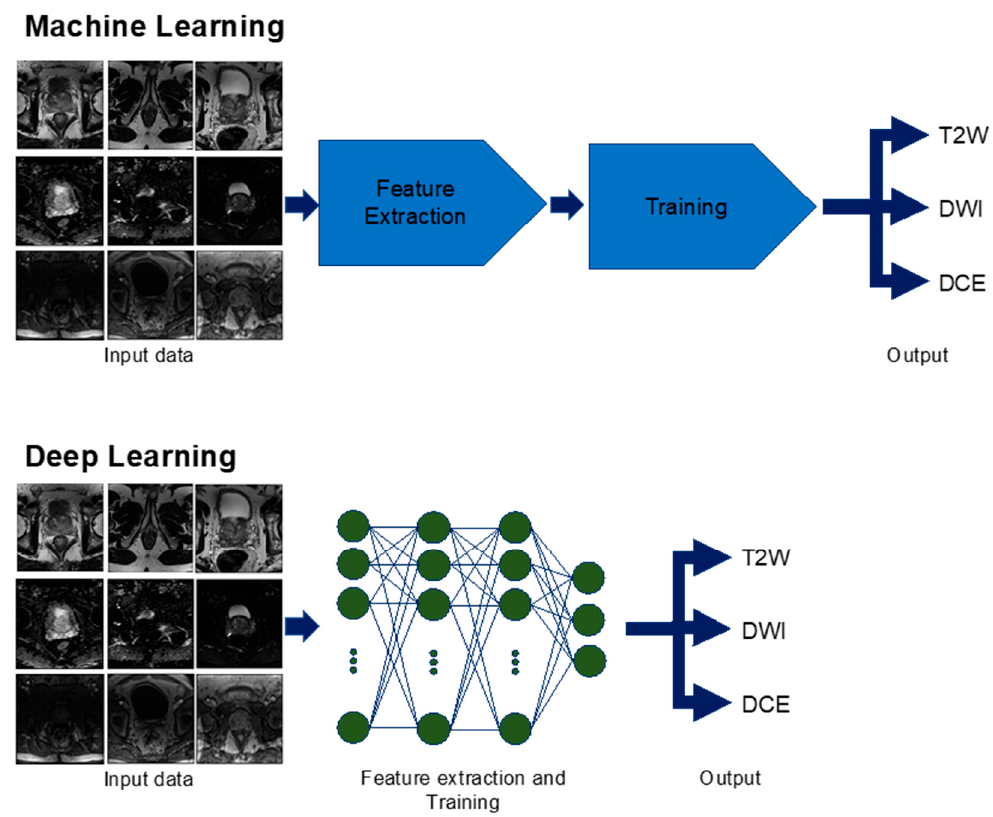
Figure 2. Machine learning versus deep learning used for multiparametric magnetic resonance imaging (mpMRI) sequence identification. In machine learning, the computer receives inputs of mpMRI images and goes through feature extraction specific to the di ff erent sequences of T2-weighted (T2W), di ff usion-weighted imaging (DWI), and dynamic contrast-enhanced (DCE). Then, the computer is trained on additional images and is able to identify the correct sequence as an output. Deep learning di ff ers from machine learning in that feature extraction and training can be done simultaneously to produce the output.